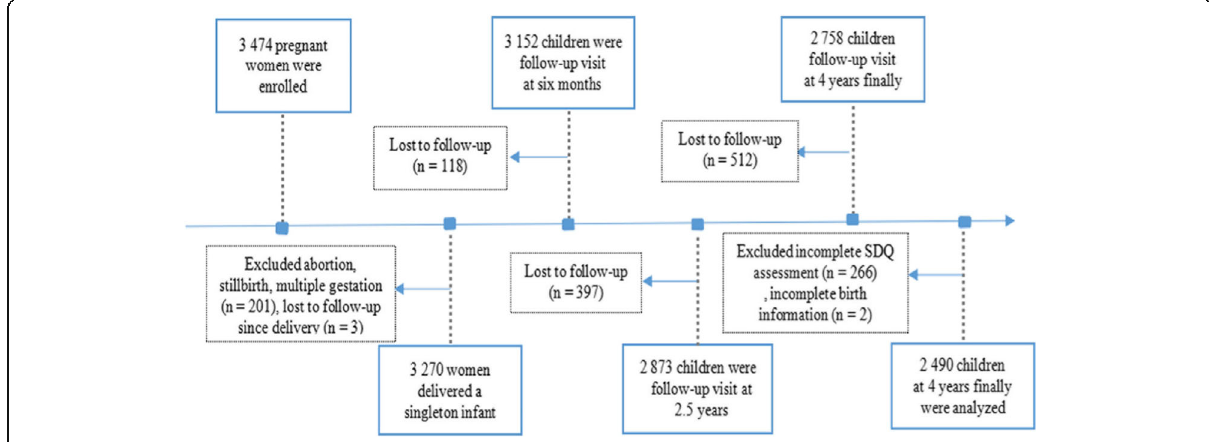
Fig. 1 The follow-up procedures involved in this study (SDQ, Strength and Difficulties